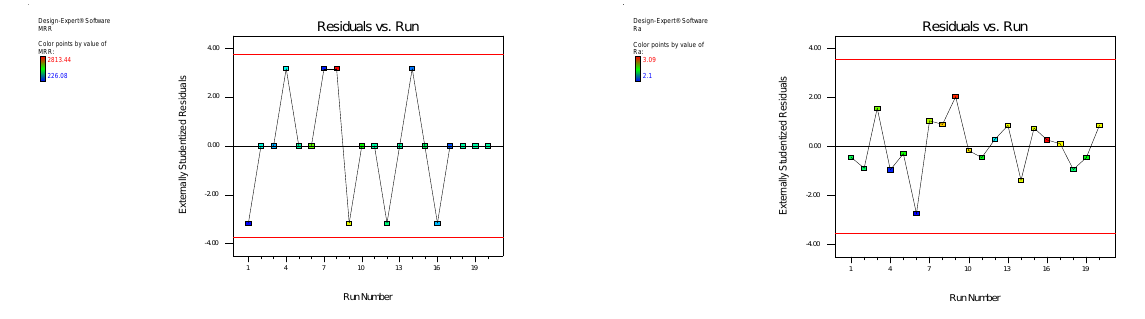
Fig. 5. Residuals vs Run plot for MRR Fig. 6. Residuals vs Run plot for Ra